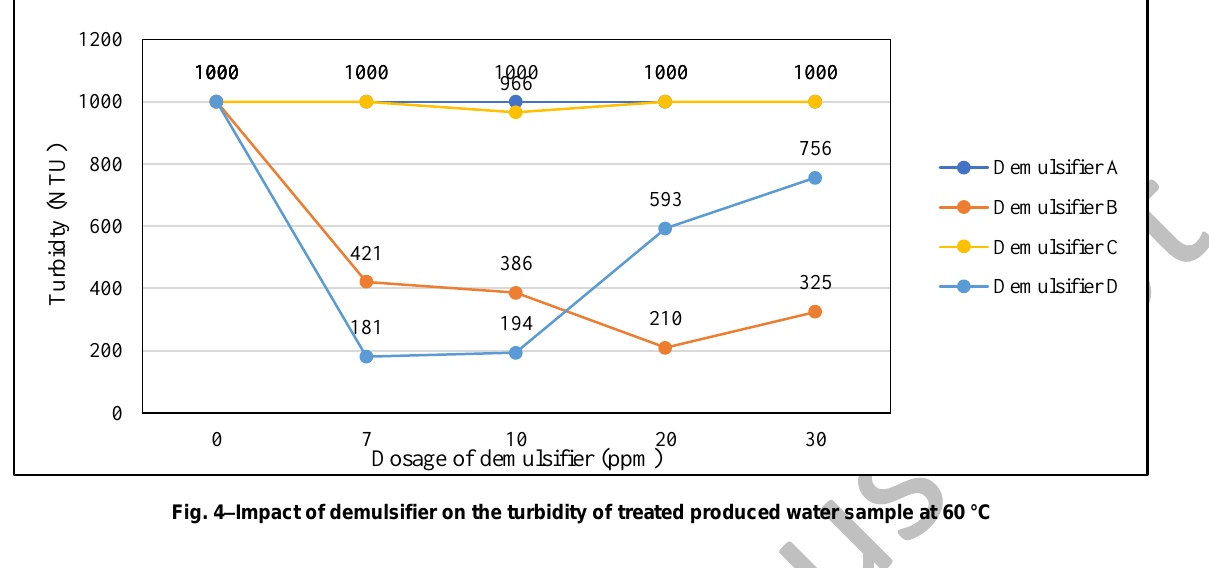
Fig. 4–Impact of demulsifier on the turbidity of treated produced water sample at 60 °C